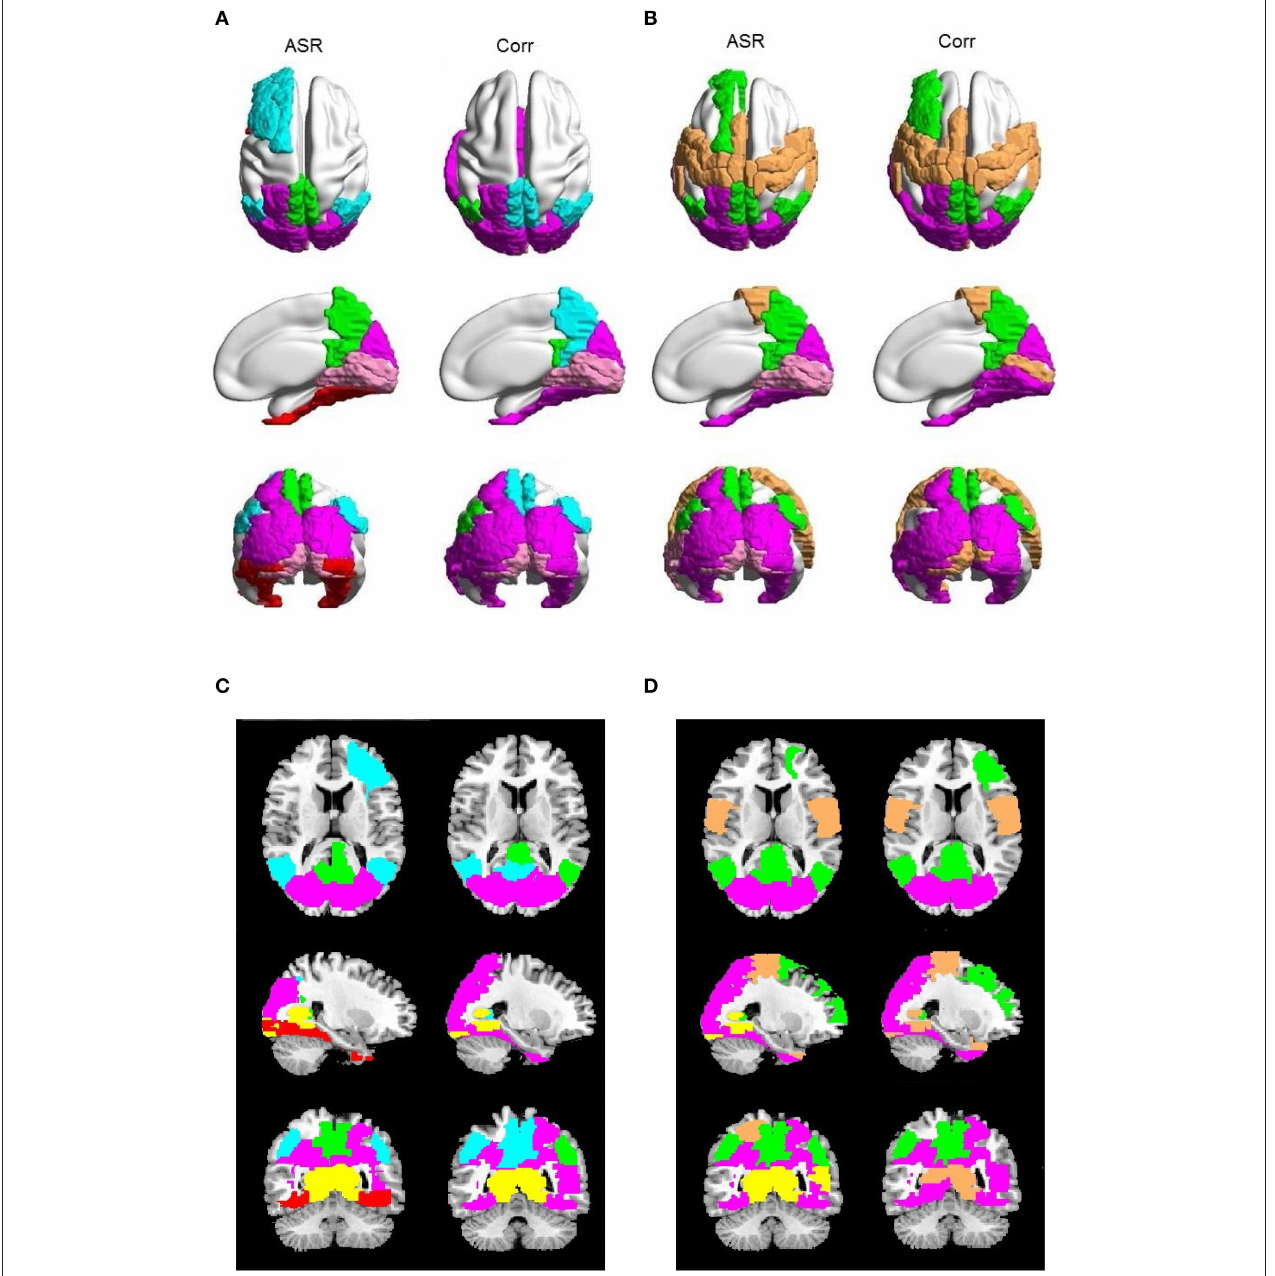
FIGURE 9 | Examples of saliently different sub-networks between ASR and the Pearson correlation on one randomly selected subject. In each panel, the results of ASR are drawn on the left side and the Pearson correlation the right side. (A) The clustering number K is 15. (B) The clustering number K is 10. Each color represents a sub-network. (C,D) are the corresponding 2D rendering of (A,B) ,